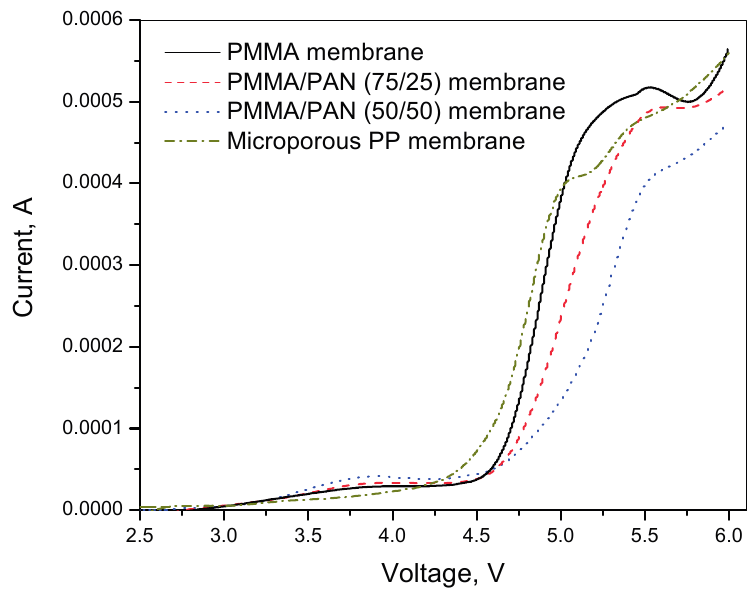
Figure 3. Electrochemical oxidation limits of PMMA membrane, PMMA/PAN (75/25) membrane, PMMA/PAN (50/50) membrane, and microporous PP